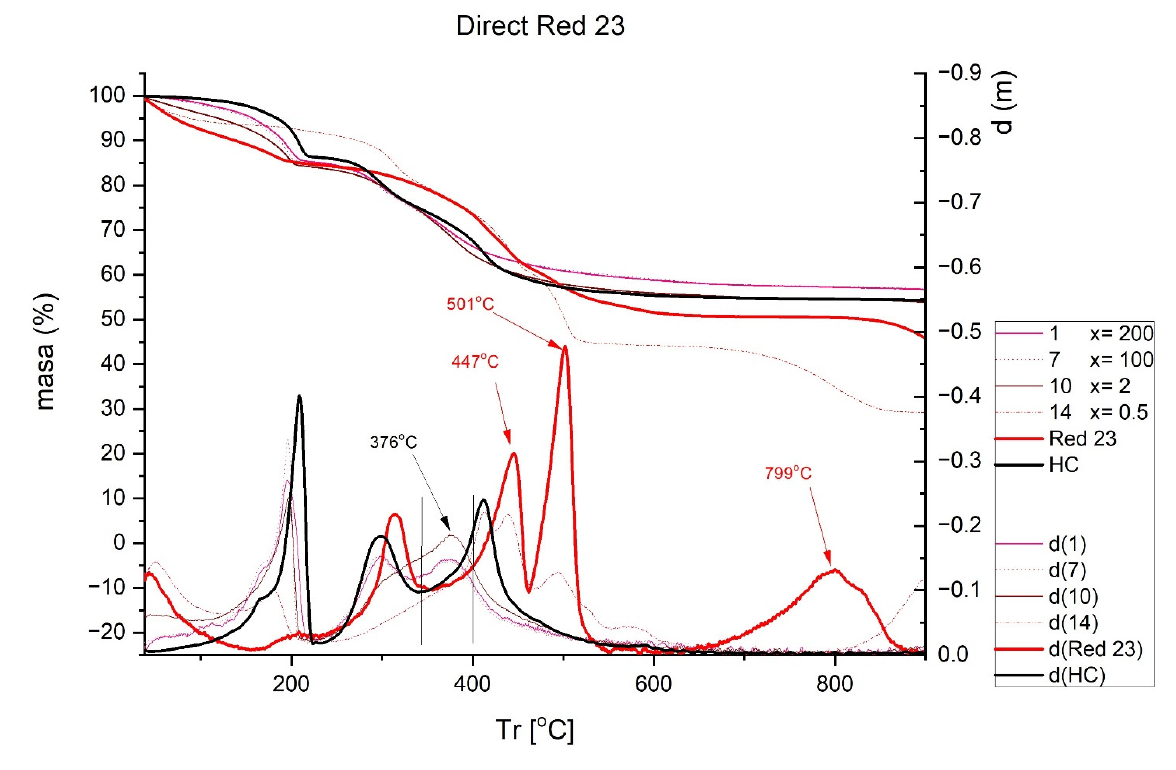
Figure 9. TGA and DTGA of Direct Red 23 free and adsorbed.